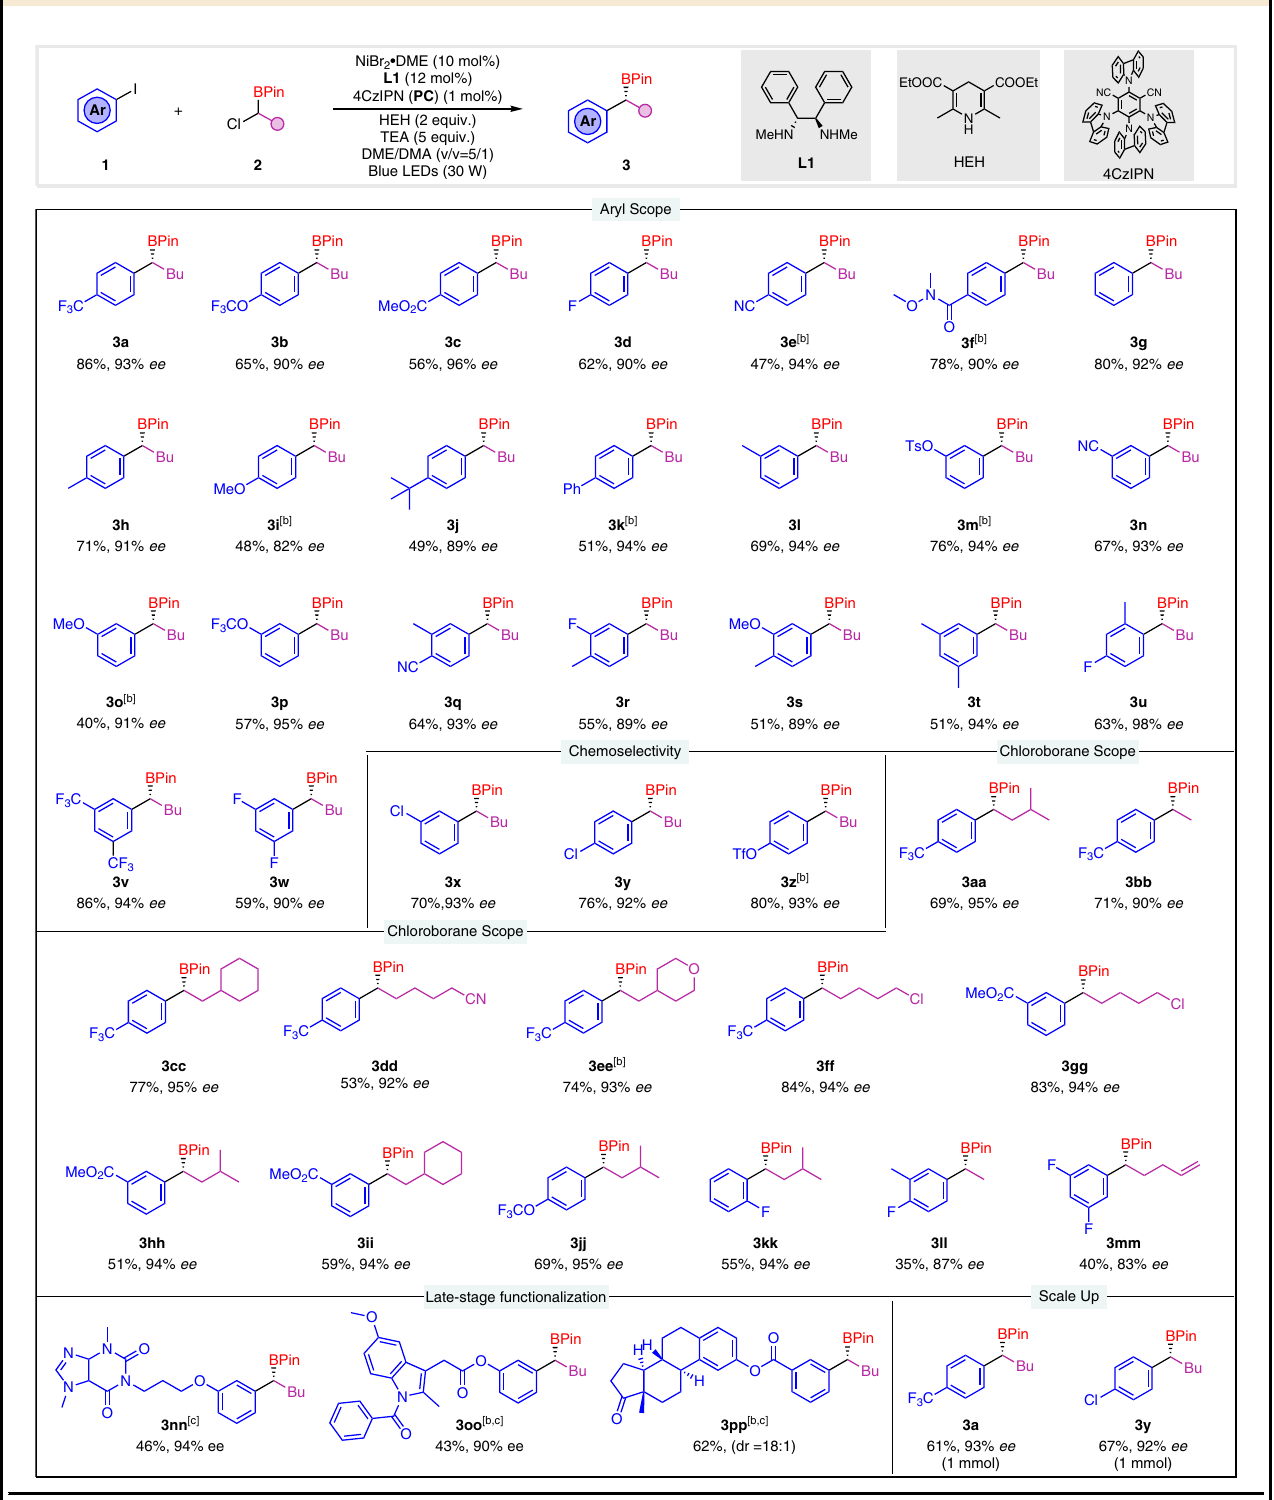
Table 2 Scope of Ni/photoredox-catalyzed coupling of aryl iodides with α -chloroboranes a